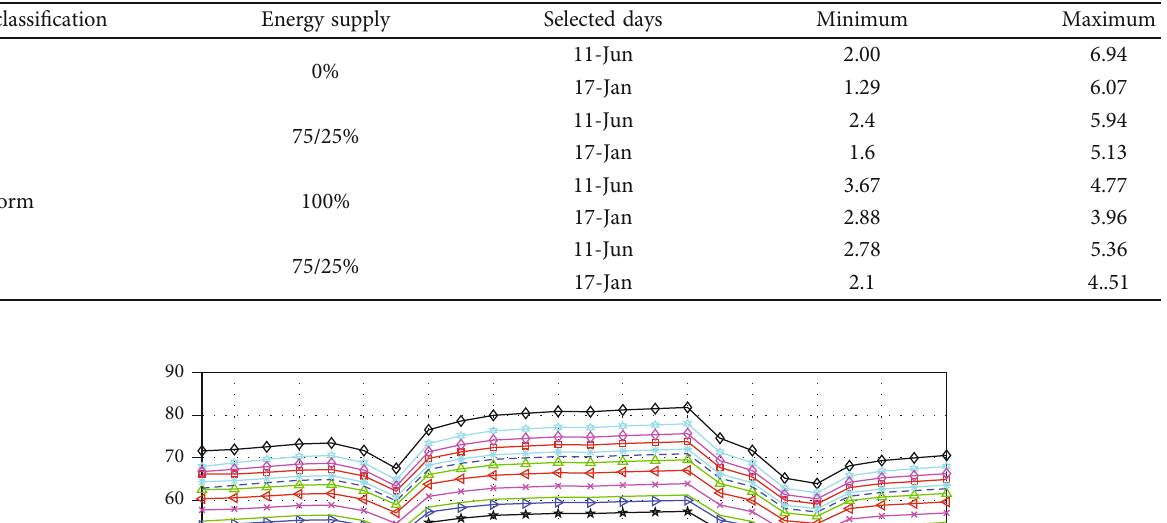
Table 7: COP summary for di ff erent cases on a selected day.